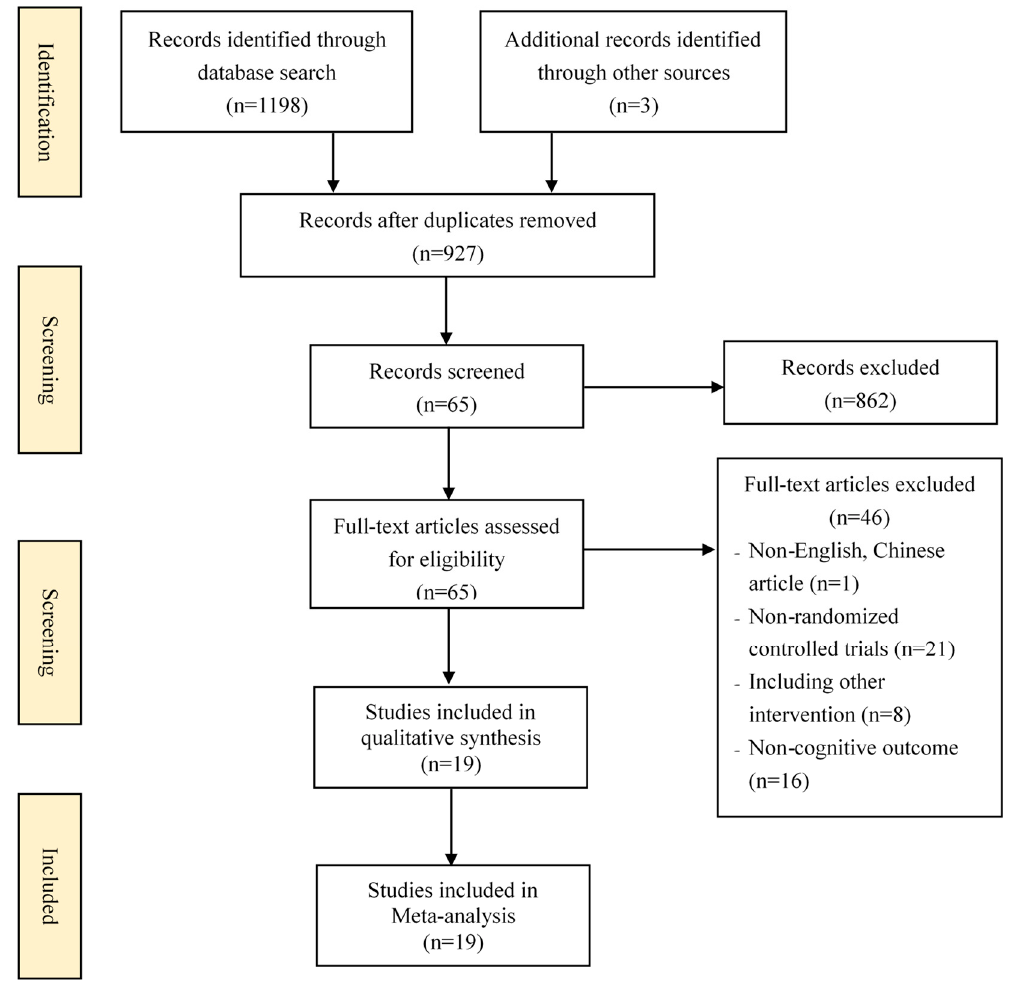
Figure 1. Flow diagram of the study selection process.